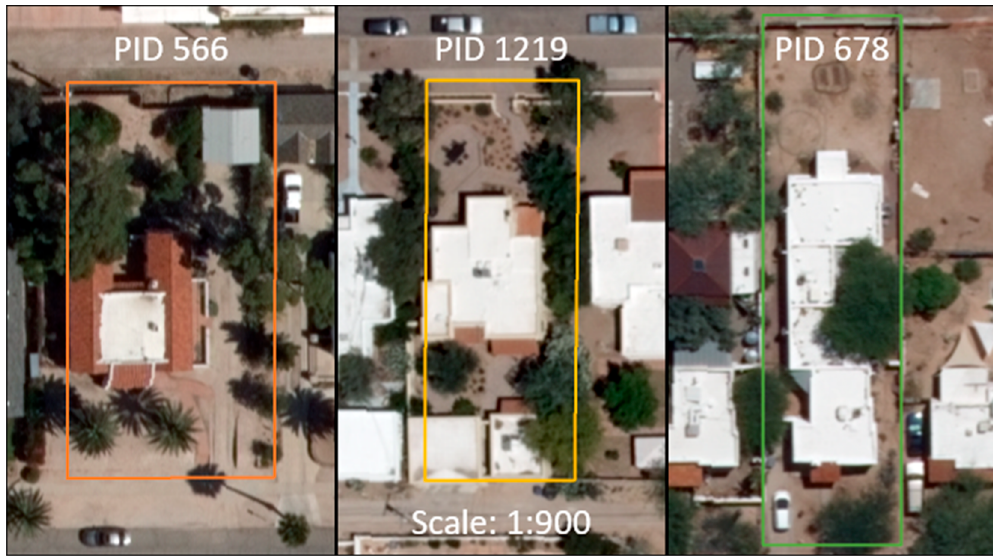
Figure 7. Parcels PID 566 ( left ), PID 1219 ( middle ), and PID 678 ( right ) represent the maximum, mean, and minimum cistern capacity for roof runoff harvesting, respectively.